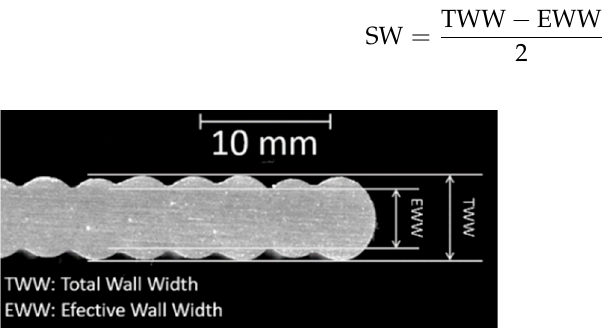
Figure 3. Geometrical features measured to characterize the surface texture of the walls [20].